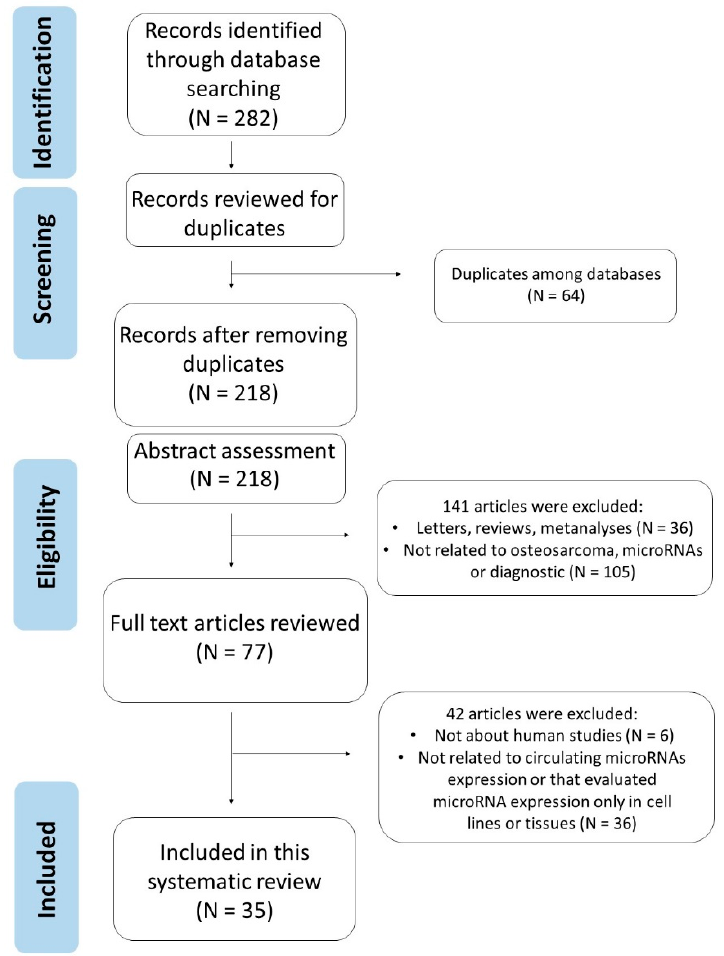
Figure 1. Overview of the literature search and selection process.